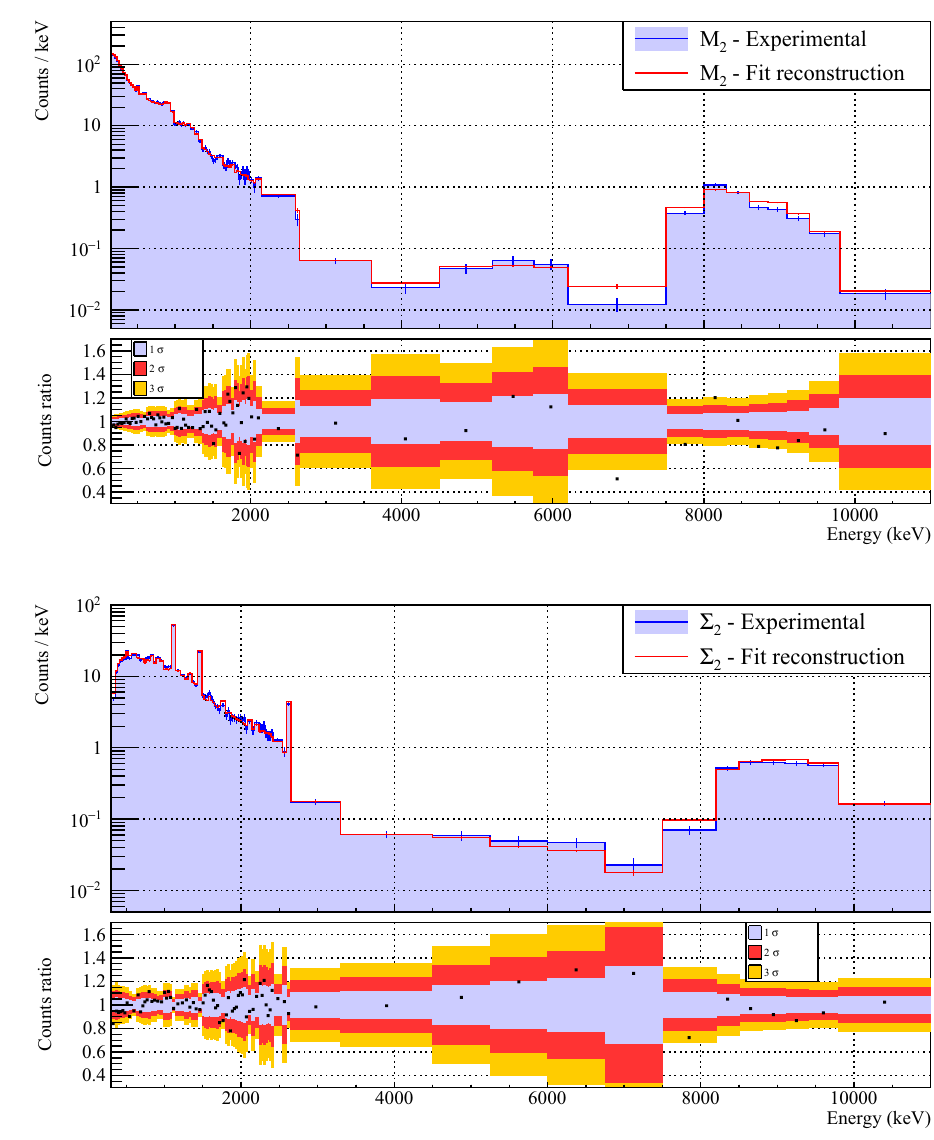
Fig. 6 Top: comparison between experimental M 2 spectrum and fit reconstruction. The lower panel shows the bin by bin ratios between counts in the experimental spectrum over counts in the reconstructed one; the corresponding uncertainties at 1, 2, 3 σ are shown as colored bands centered at 1. Bottom: same as top for Σ 2